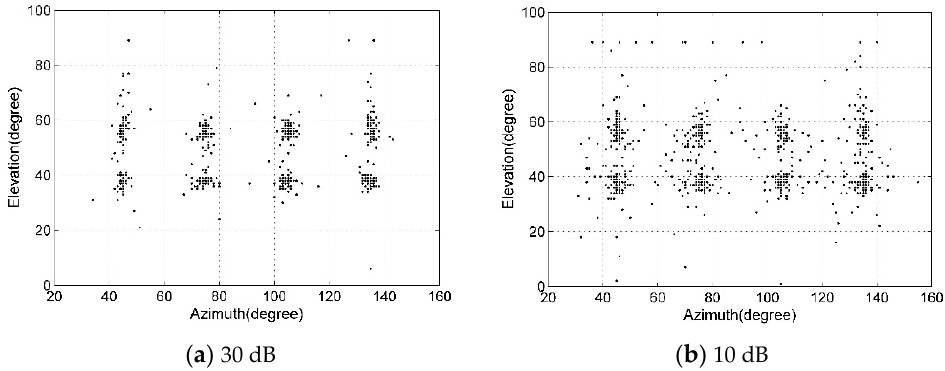
Figure 5. Sample points obtained by the first 100 frames with different SNR .